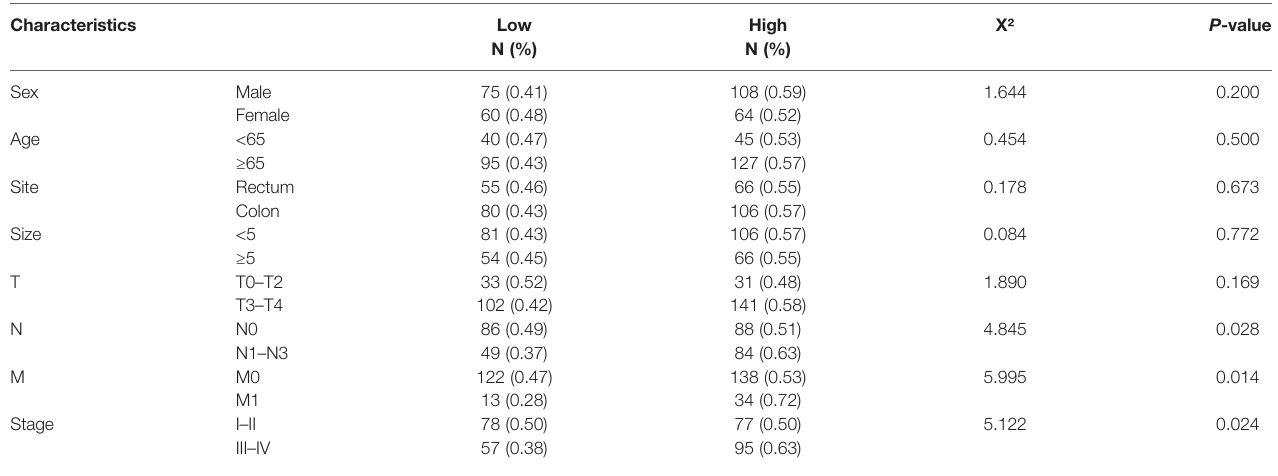
TABLE 1 | ARHGAP4 expression and clinical